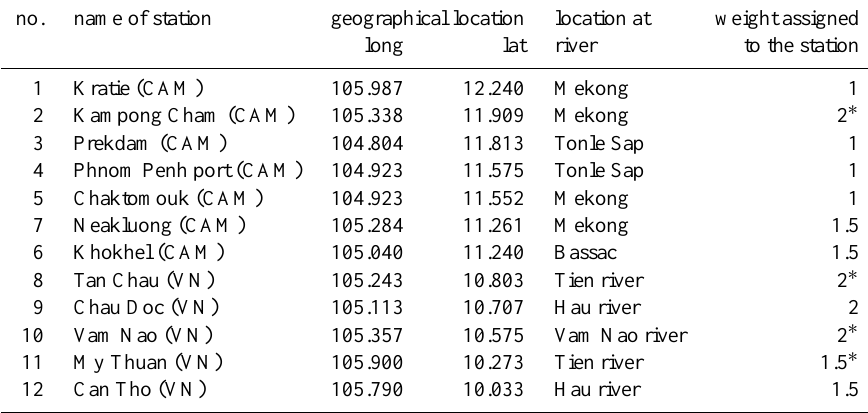
Table 1. Gauging stations used for calibrating the hydrodynamic model (data source: MRC); note: the Mekong in Cambodia is named Tien river in Vietnam, the Bassac in Cambodia is the Hau river in Vietnam. no. name of station location